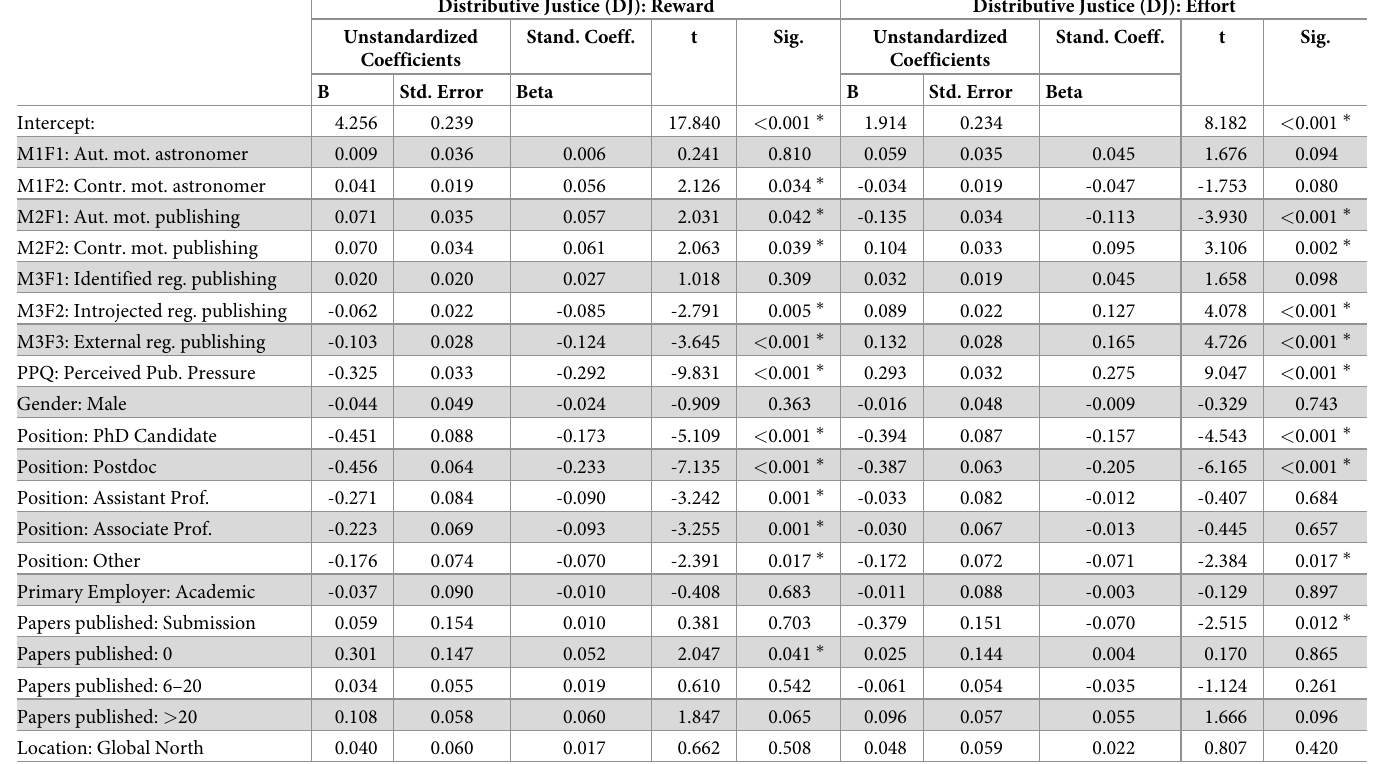
Table 7. Regression models of DV = Distributive Justice in terms of Reward & Effort; regressed onto the seven motivational factors, perceived publication pressure, and the control variables. Distributive Justice (DJ):